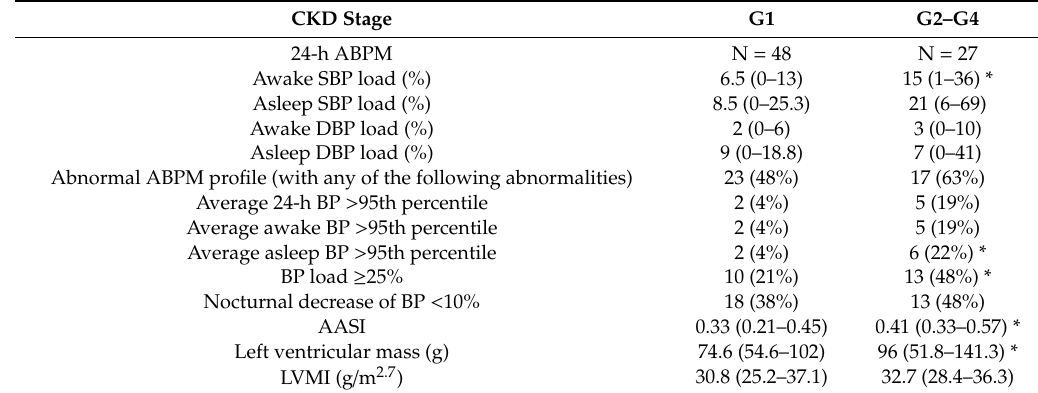
Table 2. Cardiovascular assessments in children and adolescents with chronic kidney disease (CKD) stage